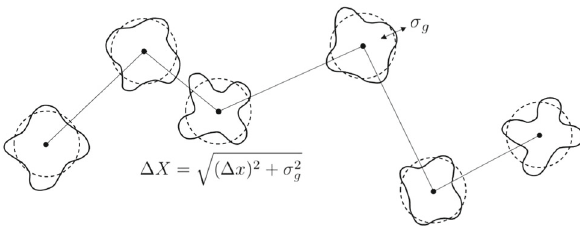
Fig. 2 Operational definition of a quantum mechanical path, in the (cid:22) ((cid:2) x ) 2 + σ 2 smeared space model, in the limit (cid:8) (cid:2) L (cid:9) (cid:14) > (cid:2) X = g . Because the background on which the particle wave function lives is no longer classical, the localisation volume undergoes stochastic fluctuations due to the relative motion of delocalised spatial ‘points’. As a result, its average radius cannot drop below the smearing scale, σ (cid:11) l ( D ) , which corresponds to the the characteristic diffusion length g Pl foradelocalised‘point’inthesmearedbackground.Thisisanalogousto the Compton wavelength in the matter sector, λ C ( m ) = ¯ h /( mc ) , which givesthecharacteristicdiffusionscaleforapoint-particlepropagatingin afixedclassicalgeometry.Notethatthisheuristicdiagramisinadequete in an important respect: the surface of the fluctuating resolution-volume is depicted as smooth, whereas, in fact, it too is fractal-like, according to our model. In a more realistic depiction, zooming in on a small section of the surface would show its discontinuous, fractal, nature. (See Fig 7.1 in Feynman and Hibbs [1], for